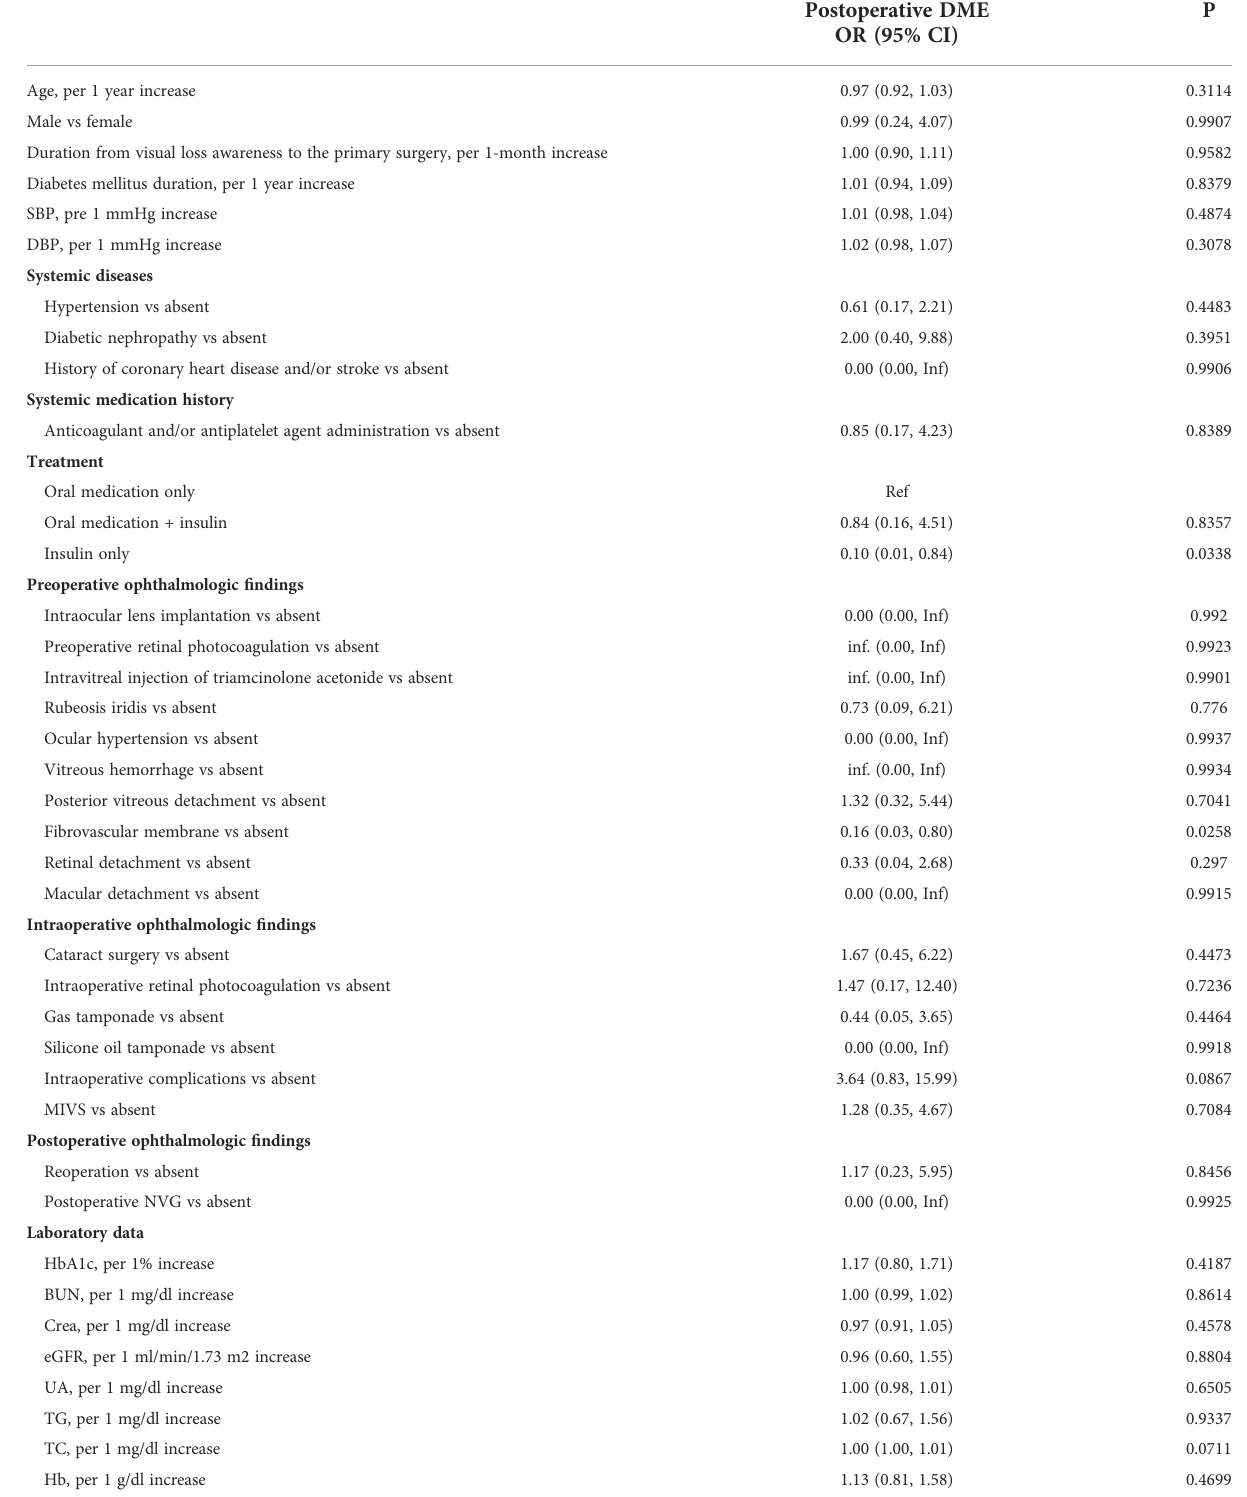
TABLE 2 The results of univariate